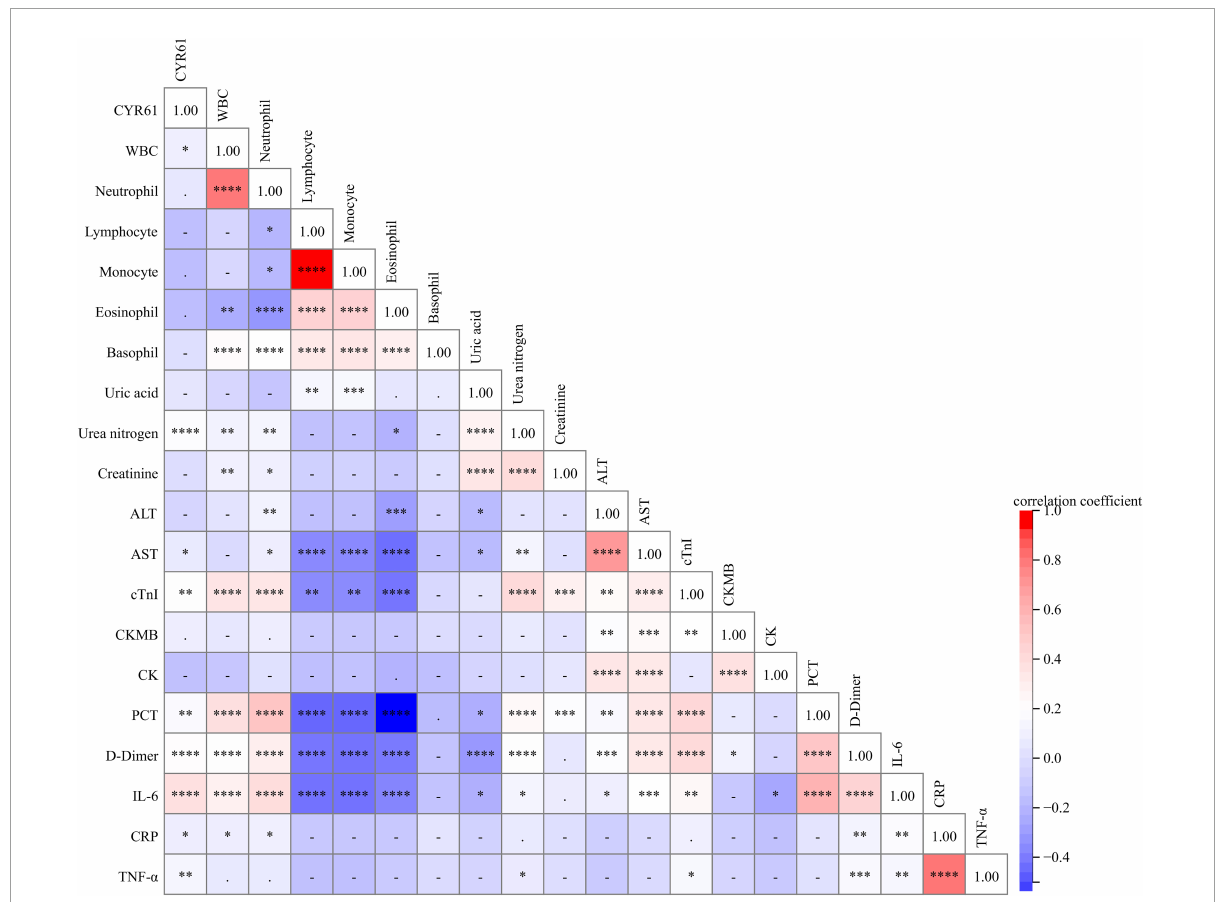
FIGURE2 The relationships between serum CYR61 and clinical characteristics in CAP patients. The relationships between serum CYR61 and clinical characteristics were analyzed in CAP patients through Spearman’s or Pearson’s correlative analysis. Different colors indicate different correlation coefficients. Red color indicates the positive correlation, and blue color indicates the negative correlation. The darker the color, the stronger the correlation. * P <0.05, ** P <0.01, *** P <0.001, **** P <0.0001.